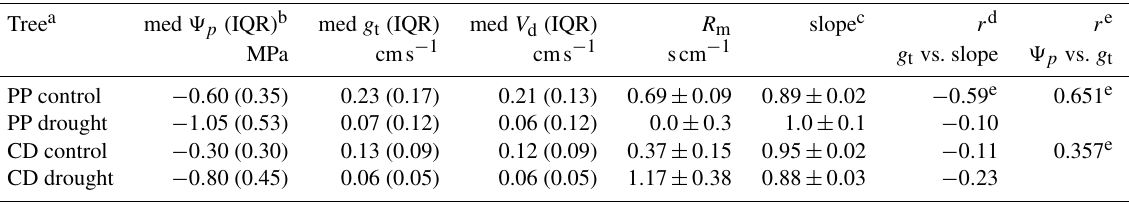
Table 3. Summary of drought stress results. Tree